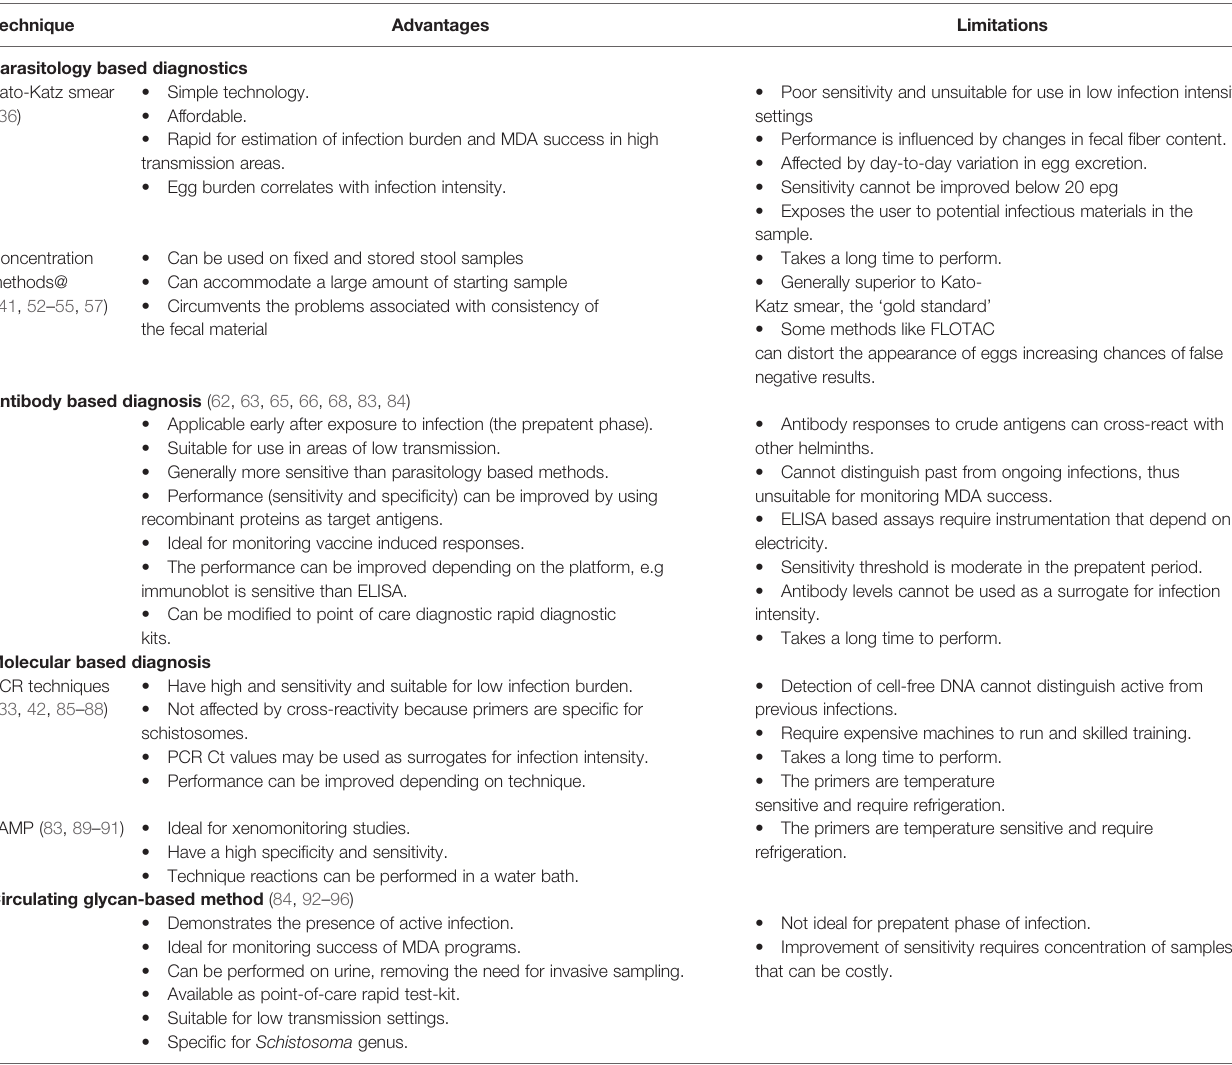
TABLE 2 | Performance characteristics of current schistosome diagnostic